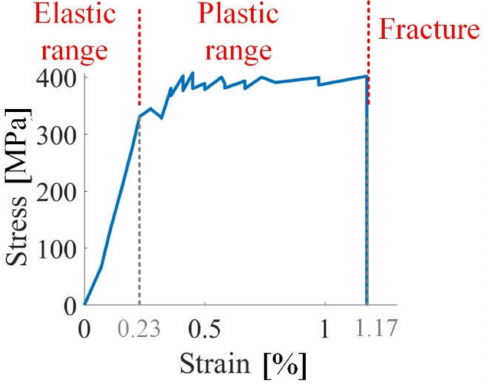
Figure 4. The stress–strain curve of silicon steel sheet sample 1.